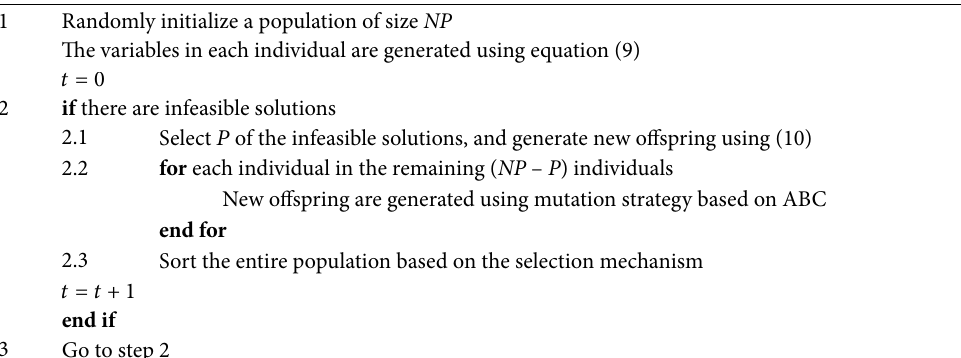
Table 4: Algorithm of the